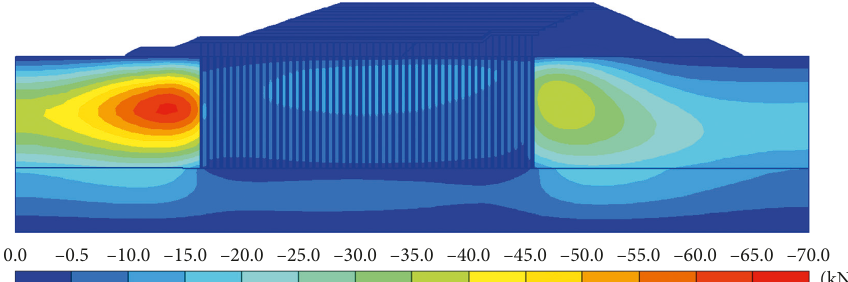
Figure 9: Contour of excess pore water pressure at the end of construction.